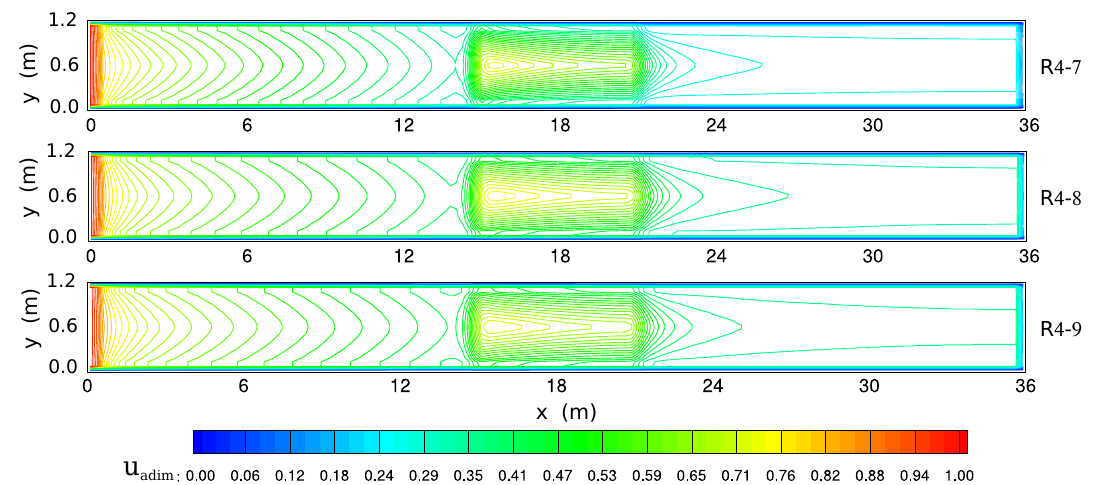
Figure 4. U velocity component in the surface layer for the three cases. Where u = U/U adim max .